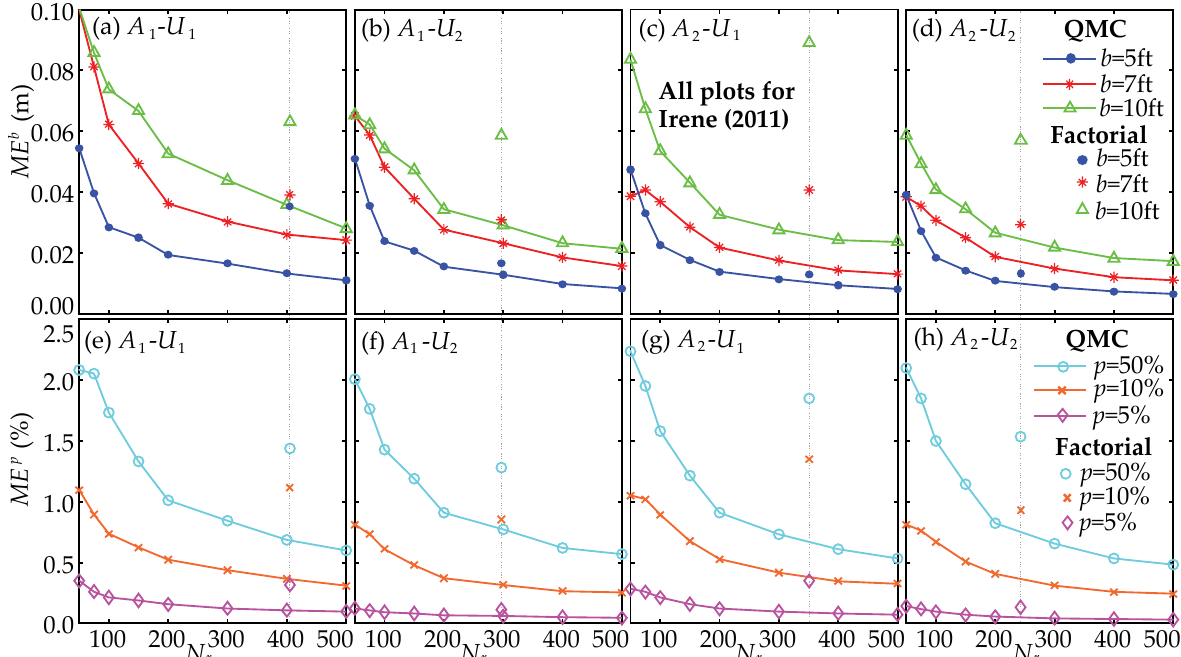
Figure 8. Accuracy metrics b ME (top row) and p ME (bottom row) for hurricane Irene (2011) for two different adviso- ries and two uncertainty scenarios. First two columns correspond to advisory A 1 and uncertainty scenarios U 1 (first col- umn) and U 2 (second column), while the two last columns correspond to advisory A 2 and uncertainty scenarios U 1 (third column) and U 2 (fourth column), respectively. Results for both the QMC (curves as function of samples) and the factorial sampling (for a specific sample size) are shown. A gray, dashed, vertical line is added to distinguish more easily the factorial sampling.